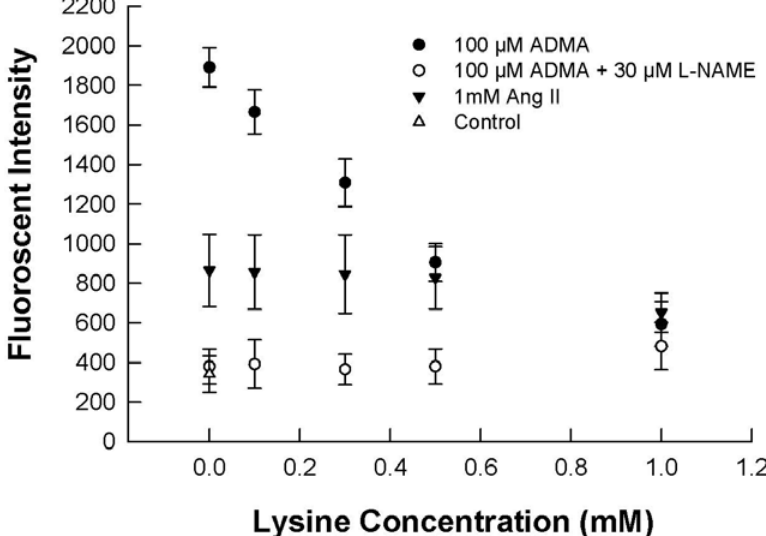
Figure 2. Effects of L -lysine and L -nitroarginine methyl ester ( L -NAME) on DHE fluorescence production from HUVEC cell membranes after exposure to 100 µM ADMA or 1 mM Ang II for 30 minutes. n =